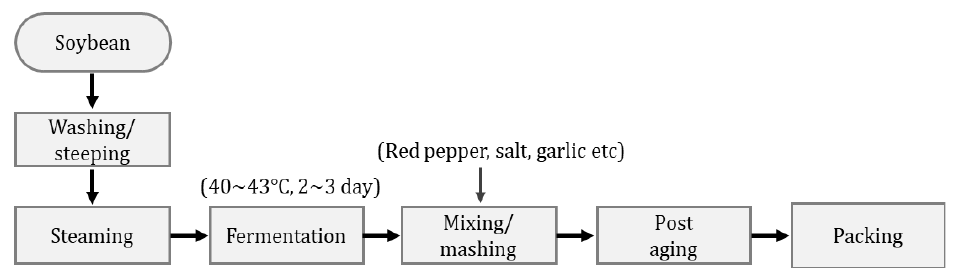
Figure 10. General manufacturing process for traditional cheonggukjang.